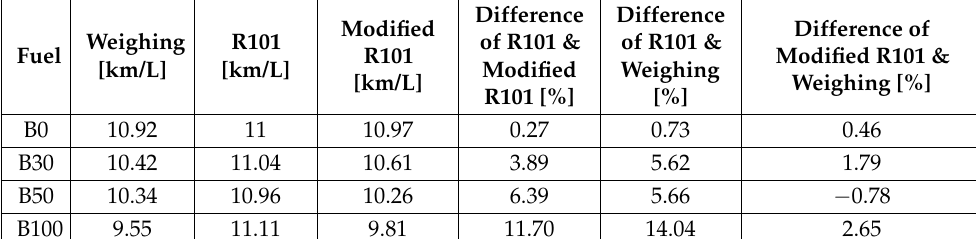
Table 4. Comparison of FE calculated by different carbon balance and weighing methods. Weighing Fuel